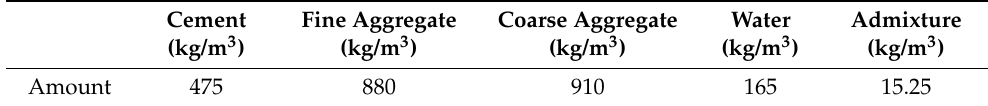
Table 2. Concrete mix proportion.